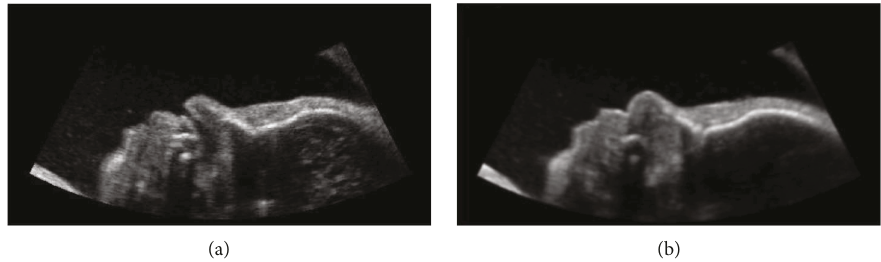
Figure 3: Smoothing: (a) slice before and (b) after application of the recursive Gaussian fi lter.